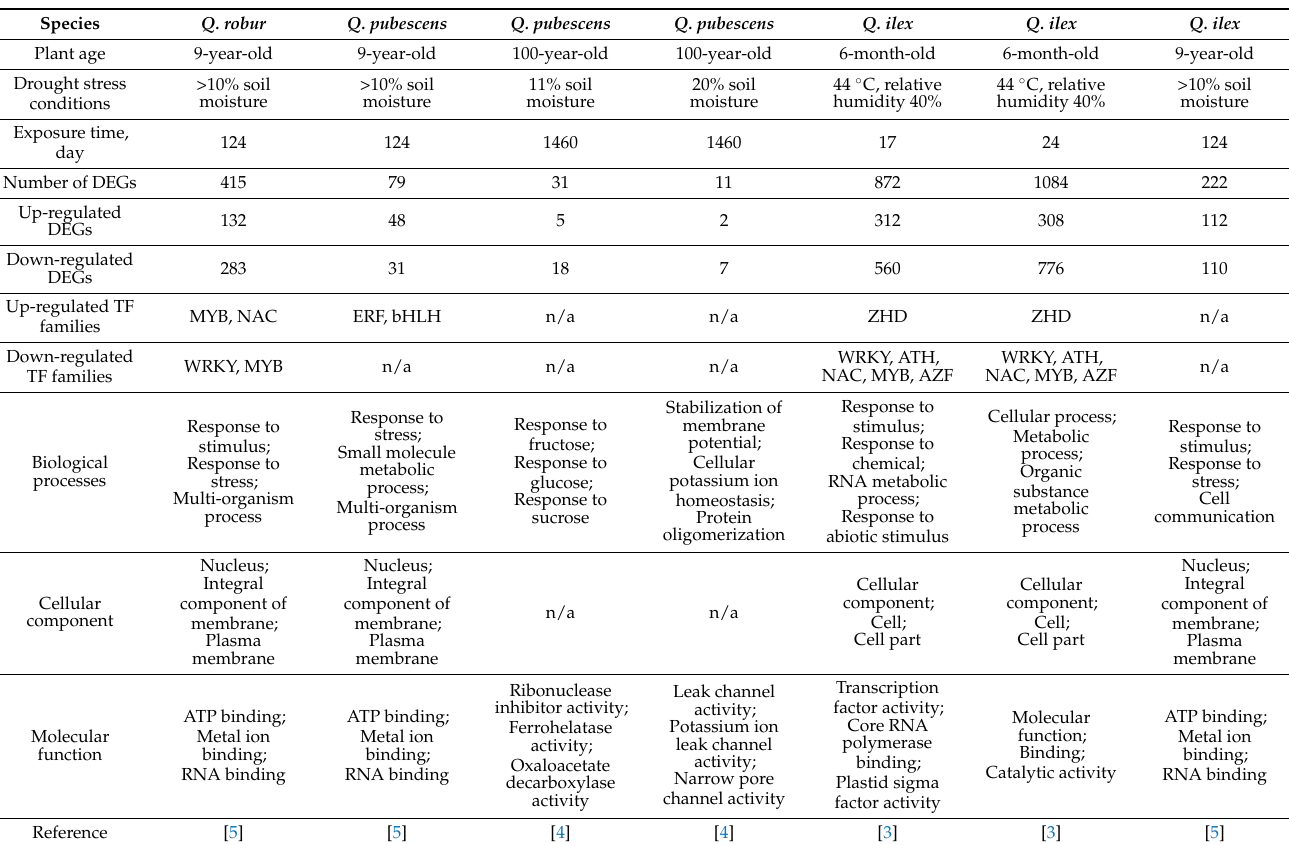
Table 1. Initial conditions and main results of differential expression analysis for Quercus spp. under drought